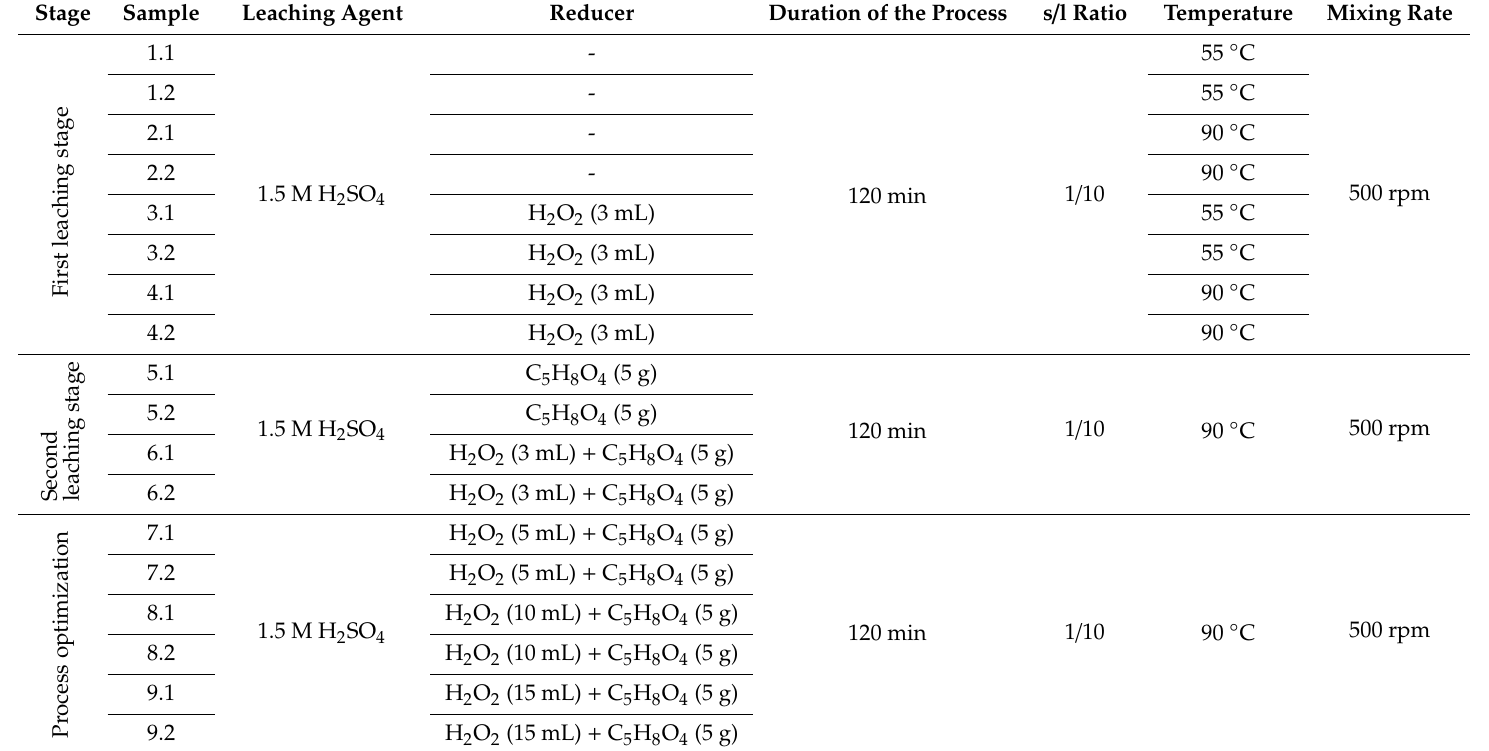
Table 1. Plan of the